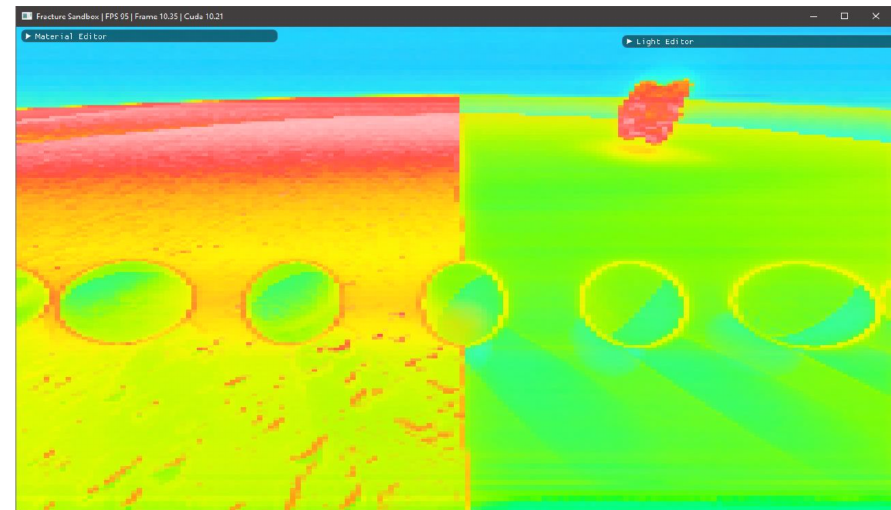
Figure 12. View 4: heatmap illustrating the clock cycle count.